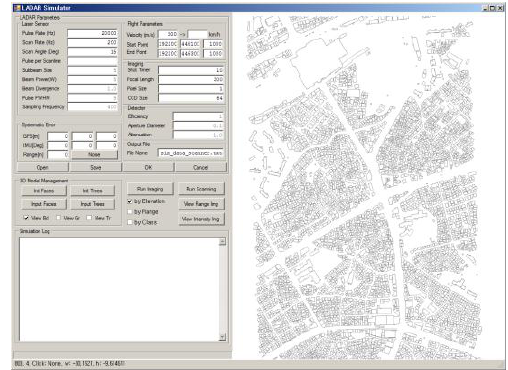
Figure 17. Implemented lidar simulation software